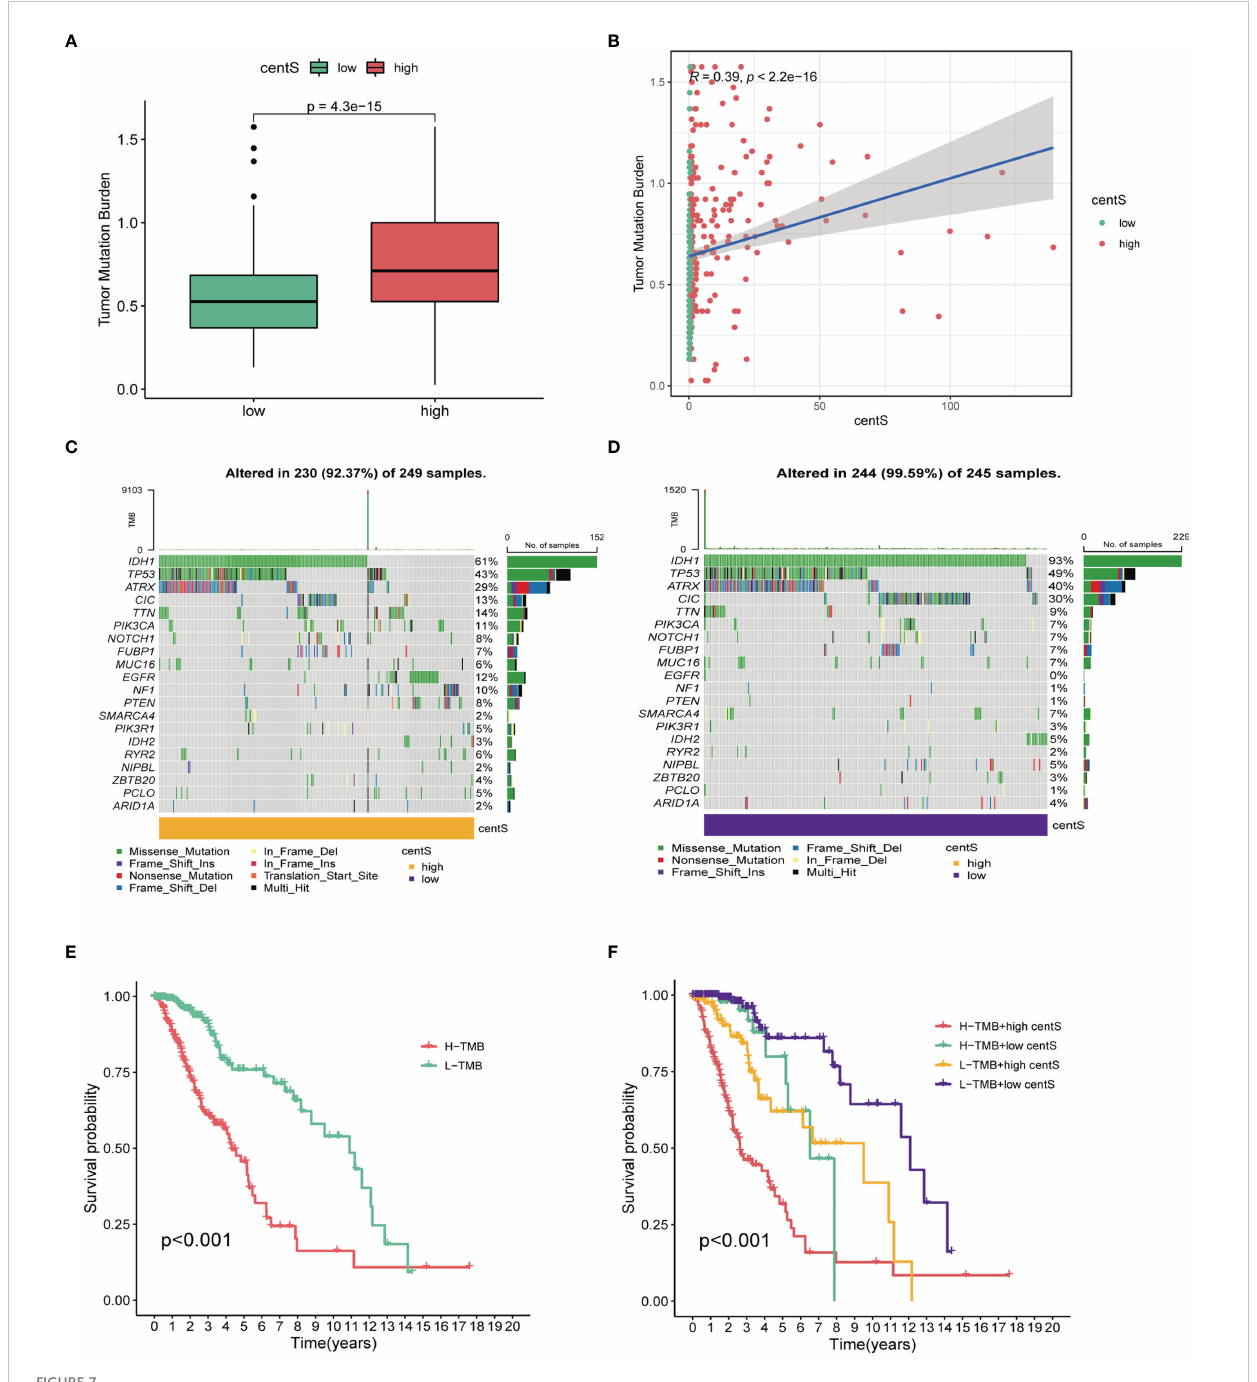
FIGURE 7 Tumor mutation analysis base on centS in TCGA-LGG cohort. (A) Difference analysis of TMB between the high- and low- centS groups. (B) Correlation analysis between centS and TMB. (C, D) Tumor mutation landscape in the high- and low- centS groups. (E) OS analysis of patients with high- and low- TMB. (F) OS analysis of patients in different combination groups of centS and TMB. centS, centrosome